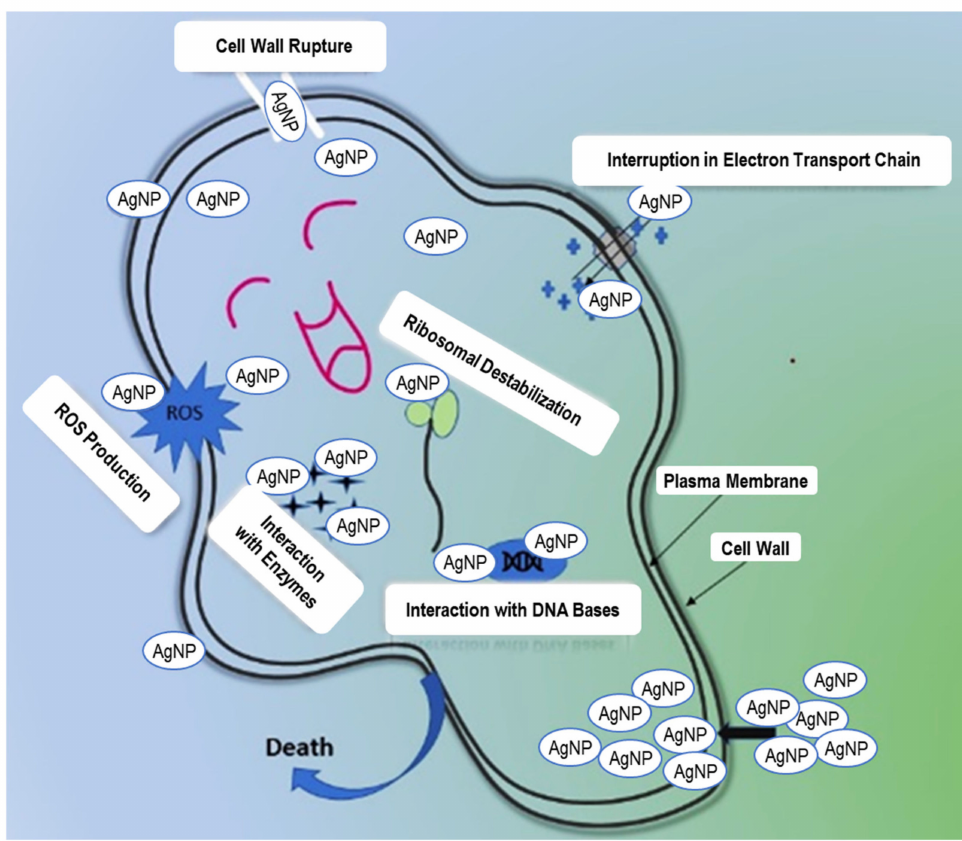
Figure 9. Possible antibacterial mechanisms for